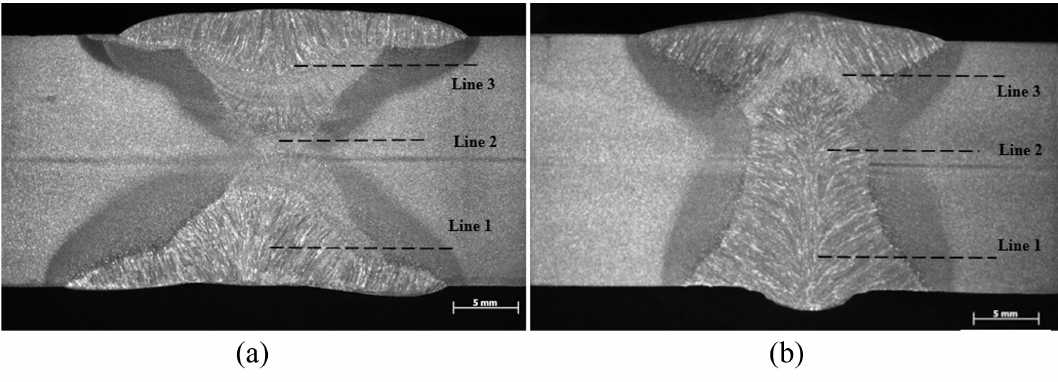
Figure 2: Weld joints showing the regions of microhardness indentations for (a) EXP1 (single wire S-SAW) and (b) EXP 2 (two wires T-SAW).